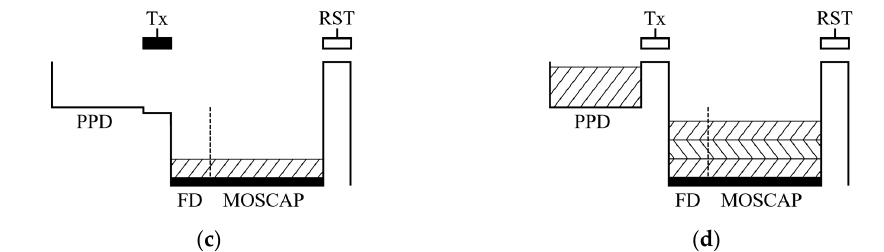
Figure 3. Potential diagram of the multiple charge transfer: ( a ) Initial potential of pinned photodiode